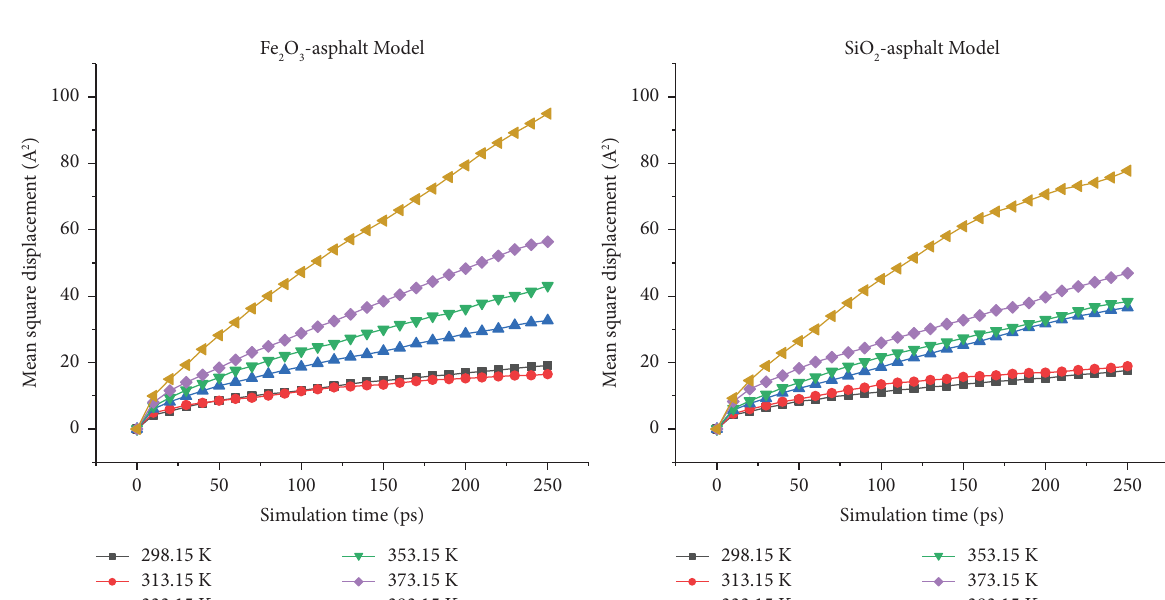
Figure 8: Mean square displacement of the Fe 2 O 3 -asphalt model and the SiO 2 -asphalt model at diferent simulated temperatures. Table 5: Fitting results of difusivity of Fe 2 O 3 -asphalt model at diferent temperatures.